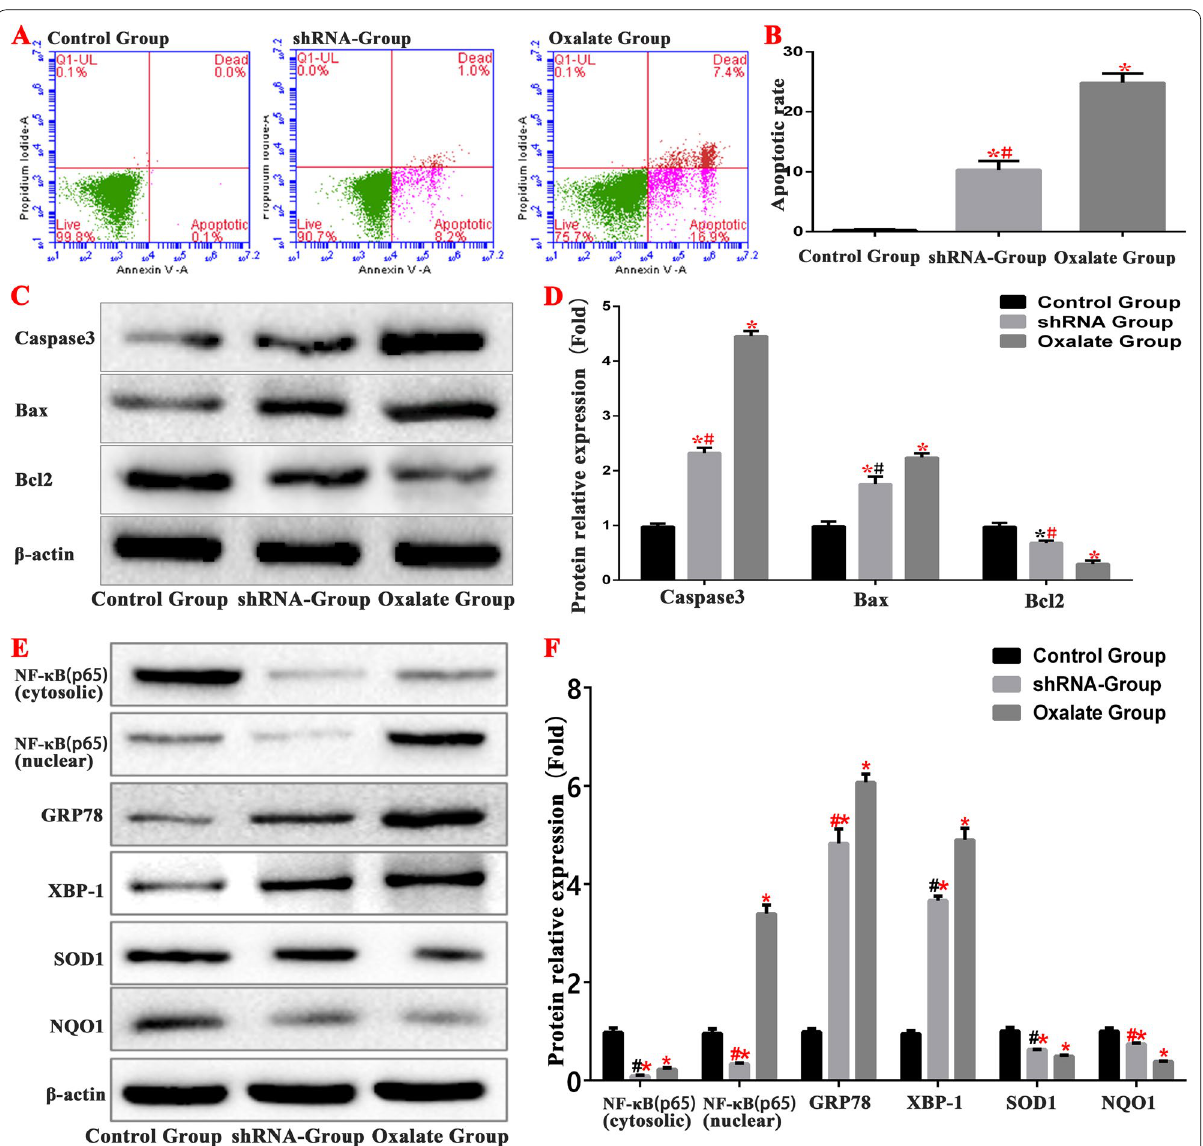
Fig. 12 Inhibition of NF-κB signaling pathway can inhibit ERS and ROS levels in cells. A , B Comparison of apoptosis detection in each group by flow cytometry. C , D Western blot was used to detect the expression of apoptosis-related proteins and NF-κB protein in each group. E , F Western blot was used to detect the expression of ERS and ROS related proteins and NF-κB protein in each group. (*compared with normal Control group, P < 0.05.* (Red) Compared with control group, P < 0.01. # Compared with oxalate group, P < 0.05. #(Red) Compared with oxalate group, P <